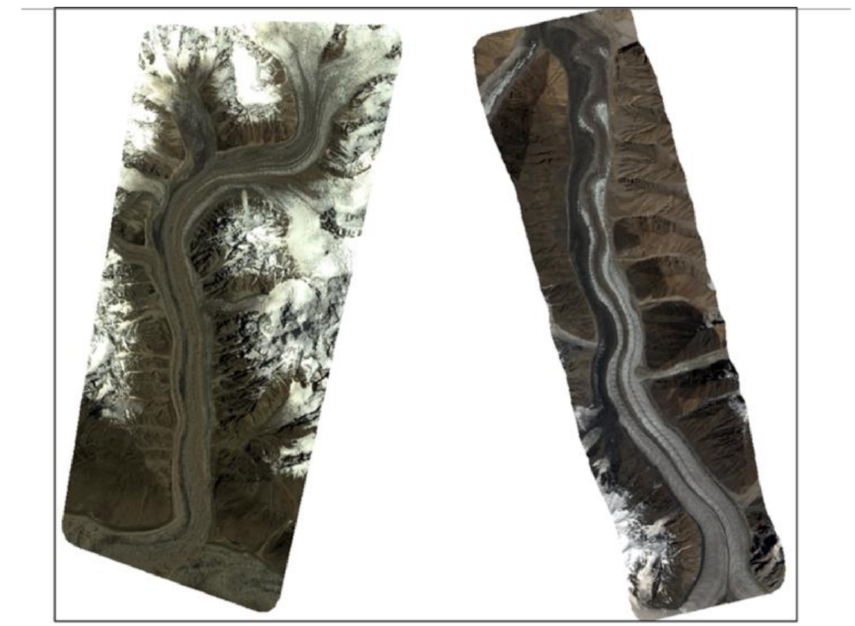
Figure 3. SPOT 7 satellite images with 1.5 m spatial